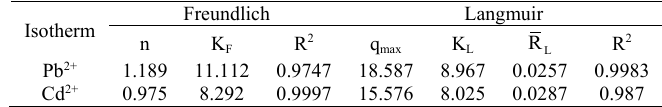
Table 1. Isotherm constant parameters of Pb 2+ and Cd 2+ adsorption with zeolite N.P./PEG/GO nano-composite Freundlich Isotherm